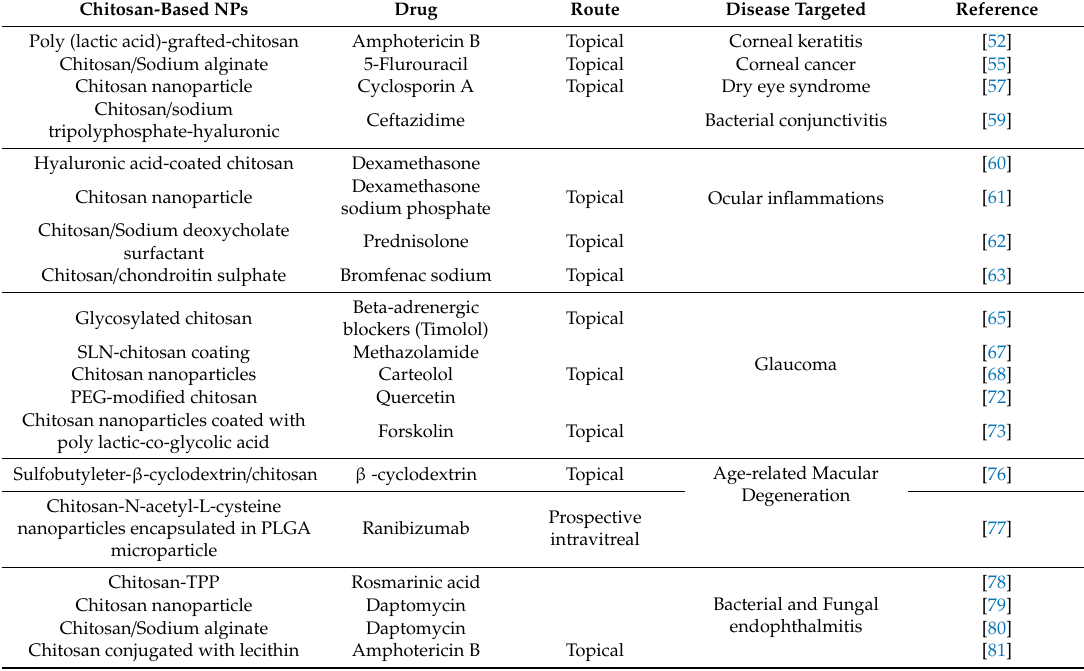
Table 2. Summary of Chitosan-based